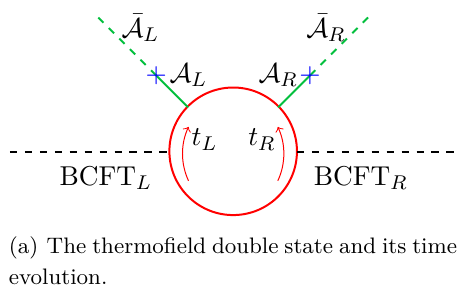
Figure 3 . a) The two Euclidean BCFTs L and R in the TFD state: time evolution is rotation with respect to the origin, hence the red circle is the time evolution of the boundary. The two black dashed lines define the zero time slice. Under the chosen time evolution, L and R evolve clockwise and counter-clockwise respectively, as indicated. We are interested in the entanglement entropy of the subsystem A = A corresponding to the solid green line segments. b) The L ∪ A R UHP which results from the conformal mapping of the region outside of the red circle in figure 3(a). (cid:1) . The location The circular boundary is mapped to the real axis and infinity is mapped to (cid:0) 0 , 1 2 of twist operators is mapped to the two blue crosses, separated in the horizontal direction. The branch cut is mapped (and deformed) to the dashed green line connecting the two